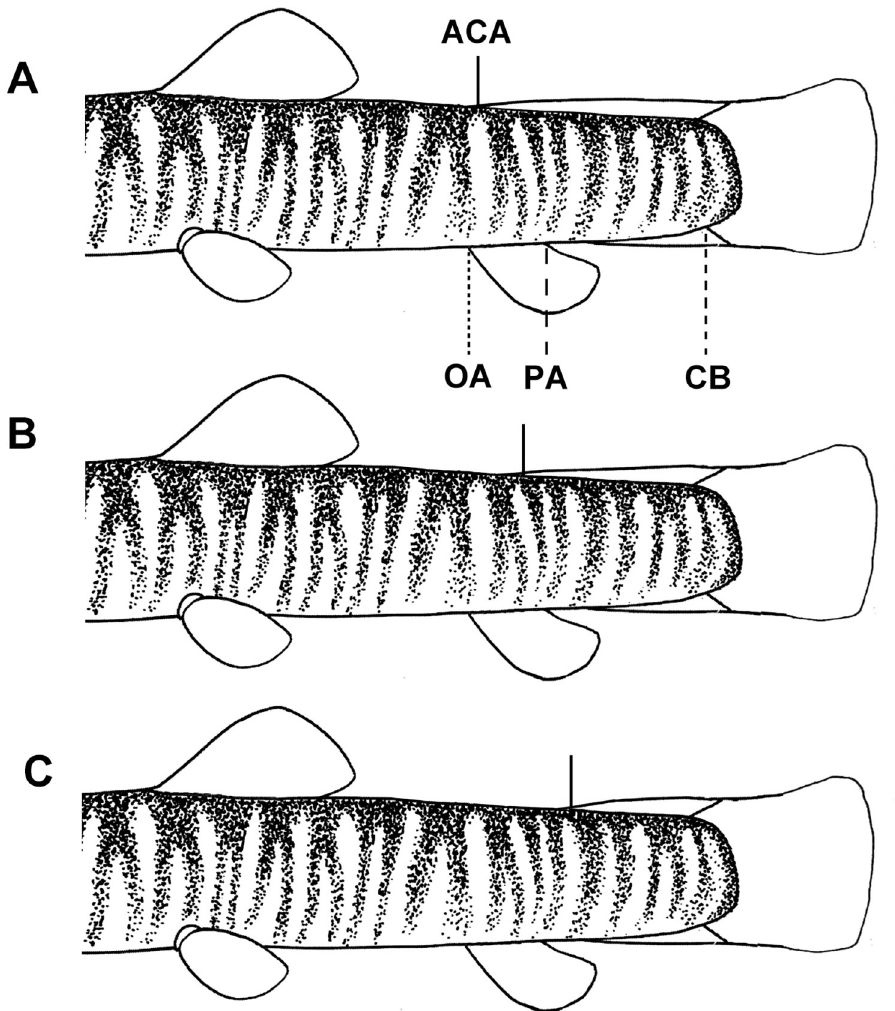
Fig 4. Location of the adipose-crest anterior along dorsal midline of caudal peduncle in Homatula . (A) Anteriorly reaching vertically through anal-fin origin; (B) Anteriorly not extending beyond vertical through the middle of the anal-fin base; (C) Anteriorly not reaching vertically through the posterior end of the anal-fin base. ACA: adipose crest anterior; CB: caudal-fin base; OA: origin of anal fin; PA: posterior of anal-fin base. base. Dorsal fin orange-yellow, two rows of brown spots on dorsal fin. Pectoral, pelvic, and anal fins orange-yellow, distal margin of each fin orange-red, and fin rays brown. Caudal fin yellowish, its distal margin orange-red. Dorsal and ventral adipose crest orange-yellow and outer margin of the upper adipose orange-red. After fixation in 95% alcohol, the body color changed from orange-yellow to brown, brown stripes and spots faded, and distal margin edge of each fin orange-red disappeared to gray. Distribution: Known from the Chuan-he in Jingdong Co., the upper Black River (Fig 5). Habitat and Ecology: Homatula geminusclathratus lives in streams with a rock matrix in valleys. The bottom of the stream was strewn with sand and gravel, and the current was swift. Homatula geminusclathratus is omnivorous, mainly feeding on algae attached to rocks, organic residue, and small aquatic insects. It usually coexists with Schistura spp. (Nemacheili- dae) and Pareuchiloglanis spp. (Sisoridae).